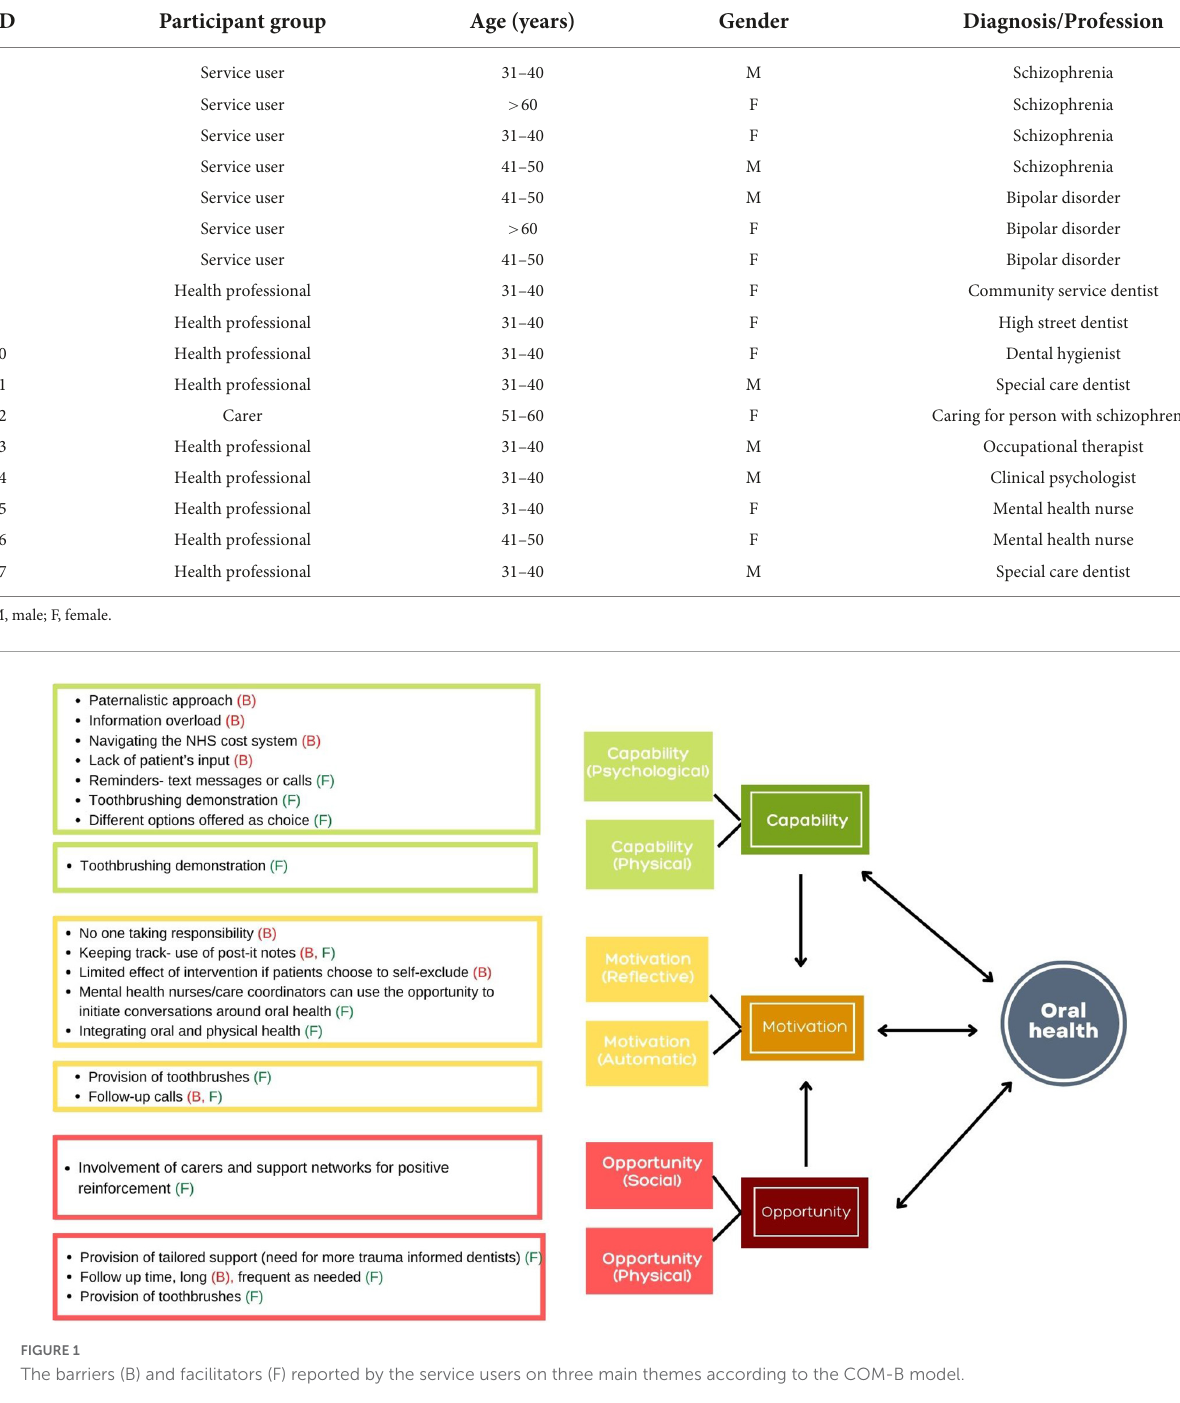
TABLE 2 Demographics of the study participants.